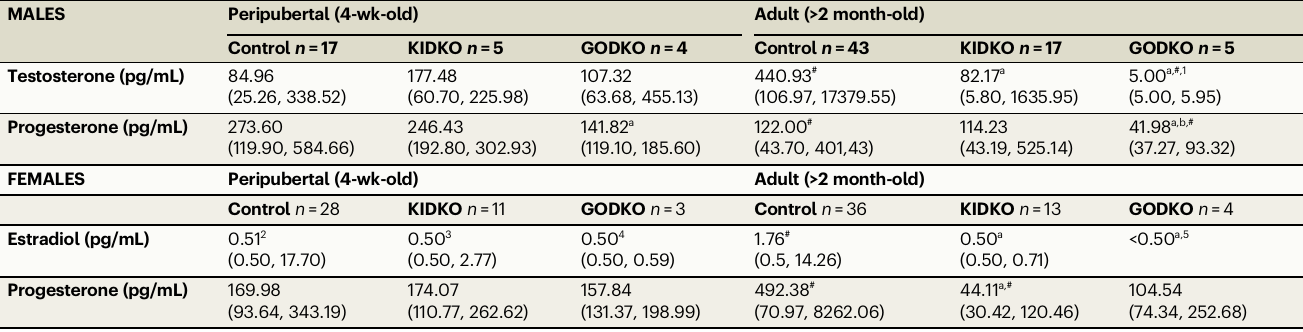
Table 1 | Circulating sex steroid levels in KiDKO and GoDKO male and female mice at two age windows: peripubertal (4-week- old) and adult (>2-month-old) MALES Peripubertal